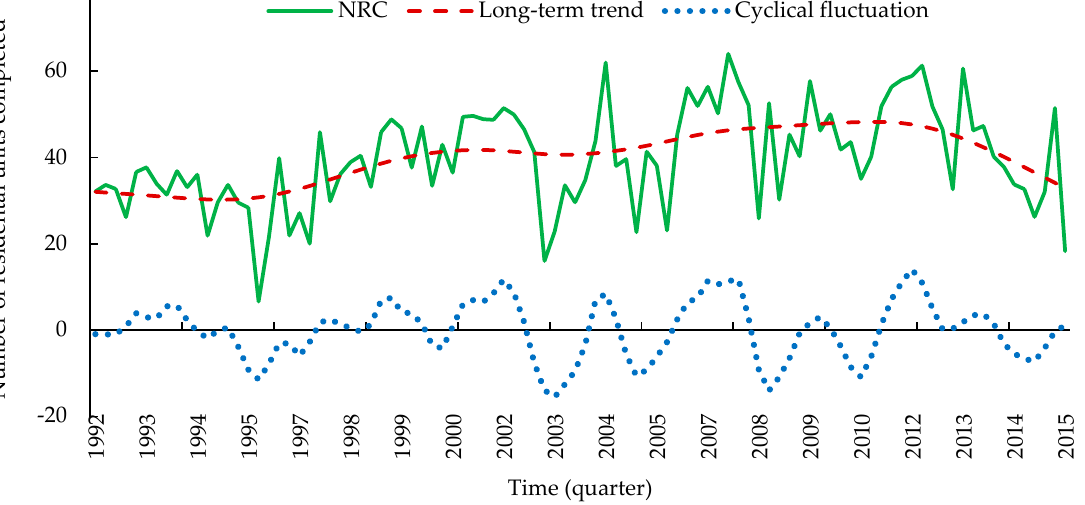
Figure 7. Decomposition of the time series of construction activities, including the number of residential completed (NRC) by private sector in urban areas of Iran in the years 1992–2015 as well as long-term trend and cyclical fluctuation.